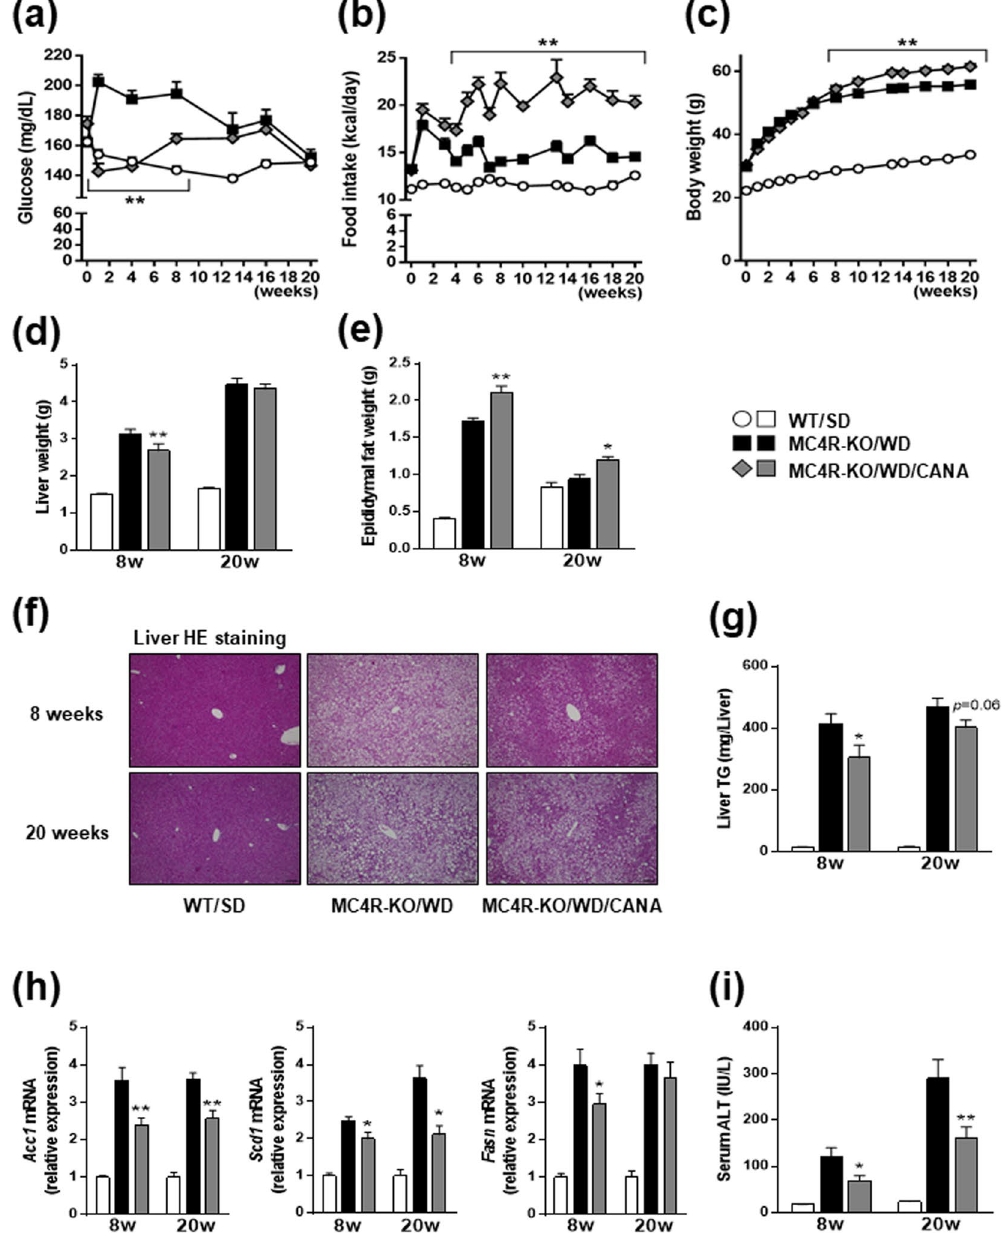
Figure 1. CANA attenuates hepatic steatosis in WD-fed MC4R-KO mice. The changes in ( a ) blood glucose level, ( b ) food intake, and ( c ) body weight during CANA treatment for 20 weeks. Weights of the ( d ) liver and ( e ) epididymal fat after 8 and 20 weeks of CANA treatment. ( f ) Hematoxylin and eosin (HE) staining and ( g ) triglyceride (TG) content of the liver. ( h ) Expression levels of lipogenesis-related genes in the liver. ( i ) Serum ALT levels. WT, wild type; SD, standard diet; WD, Western diet; CANA, canagliflozin. Original magnification, x200. Scale bars, 100 μ m. * p < 0.05, ** p < 0.01 vs MC4R-KO/WD. Statistical analyses were performed using two-way ( a , b and c ) or one-way ANOVA ( d , e , g , h and i ) followed by Bonferroni post hoc test; MC4R-KO/WD and MC4R-KO/WD/CANA was pre-selected as a subset of means to compare. n =